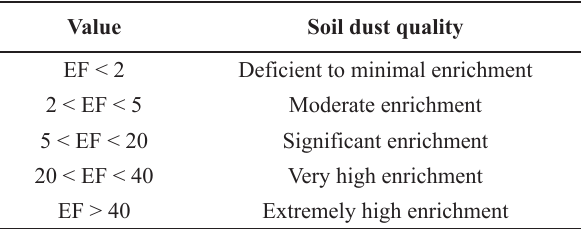
Table 2: EF categories (Barbieri et al .,